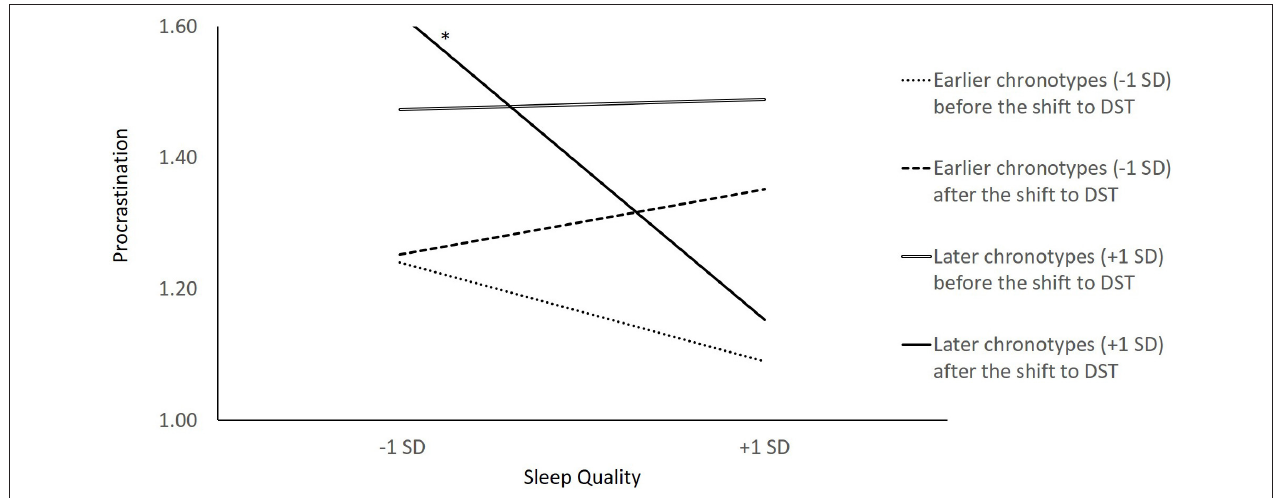
FIGURE 2 | Relationship between day-specific sleep quality and procrastination for earlier ( − 1 SD ) vs. later ( + 1 SD ) chronotypes before vs. after the shift to daylight saving time.